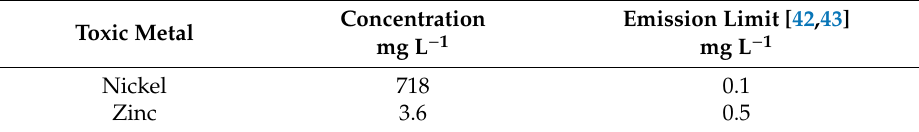
Table 4. Content of monitored hazardous metals from wastewater after